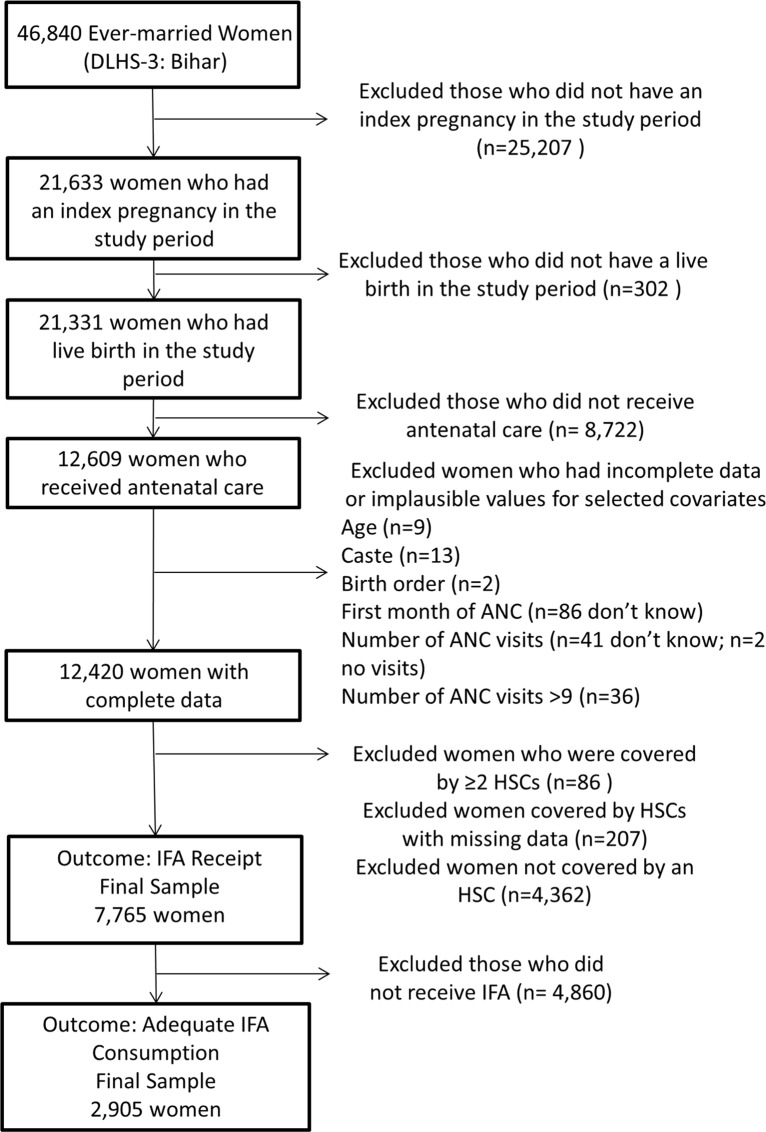
Flowchart of ever-married women exclusions and final sample.Flowchart of exclusions and final sample of ever-married women surveyed in Bihar through DLHS-3. DLHS: District Household Survey; ANC: Antenatal care; HSC: Health Sub-Center; IFA: iron and folic acid tablets or syrup.